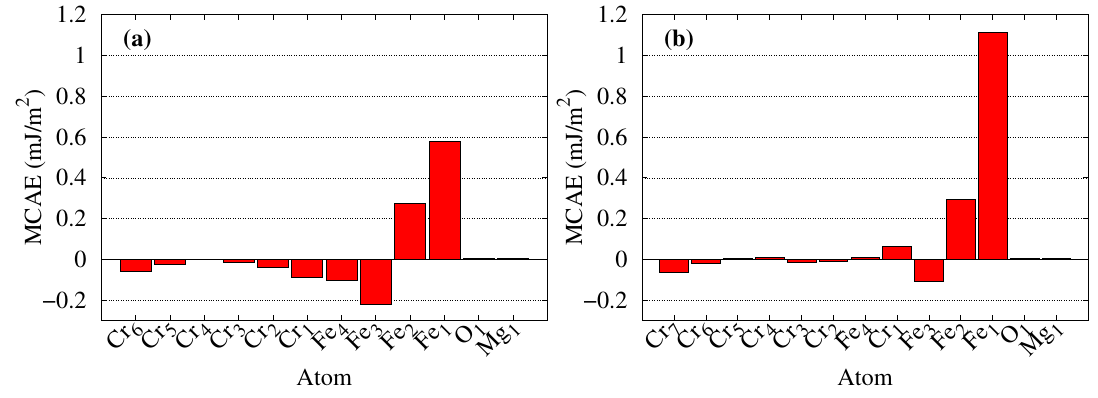
Figure 3. Atom resolved MCAE for ( a ) structure-I and ( b ) structure-II. Table 2. Orbital-resolved MCAE for the structure-I.